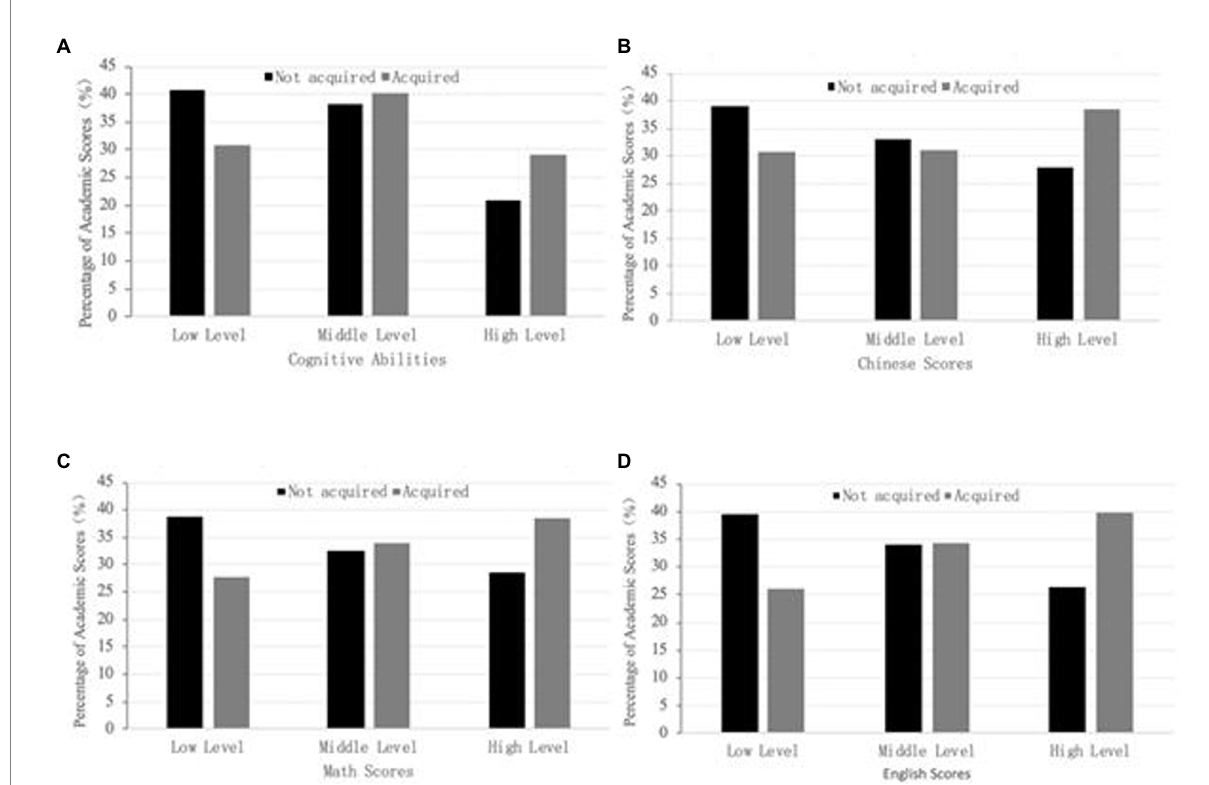
FIGURE 1 Shadow education acquisition and the percentage of academic performance. (A) Shadow education acquisition and cognitive abilities. (B) Shadow education acquisition and Chinese scores. (C) Shadow education acquisition and math scores. (D) Shadow education acquisition and English